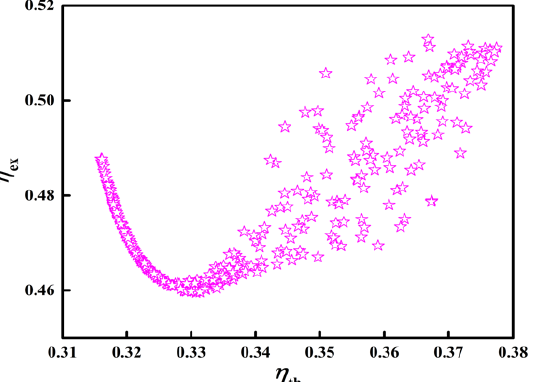
26 of 34 Figure 11. Pareto optimal solution for η th and η ex . Table 6. The partial Pareto optimal solution for η th and η ex . Factor